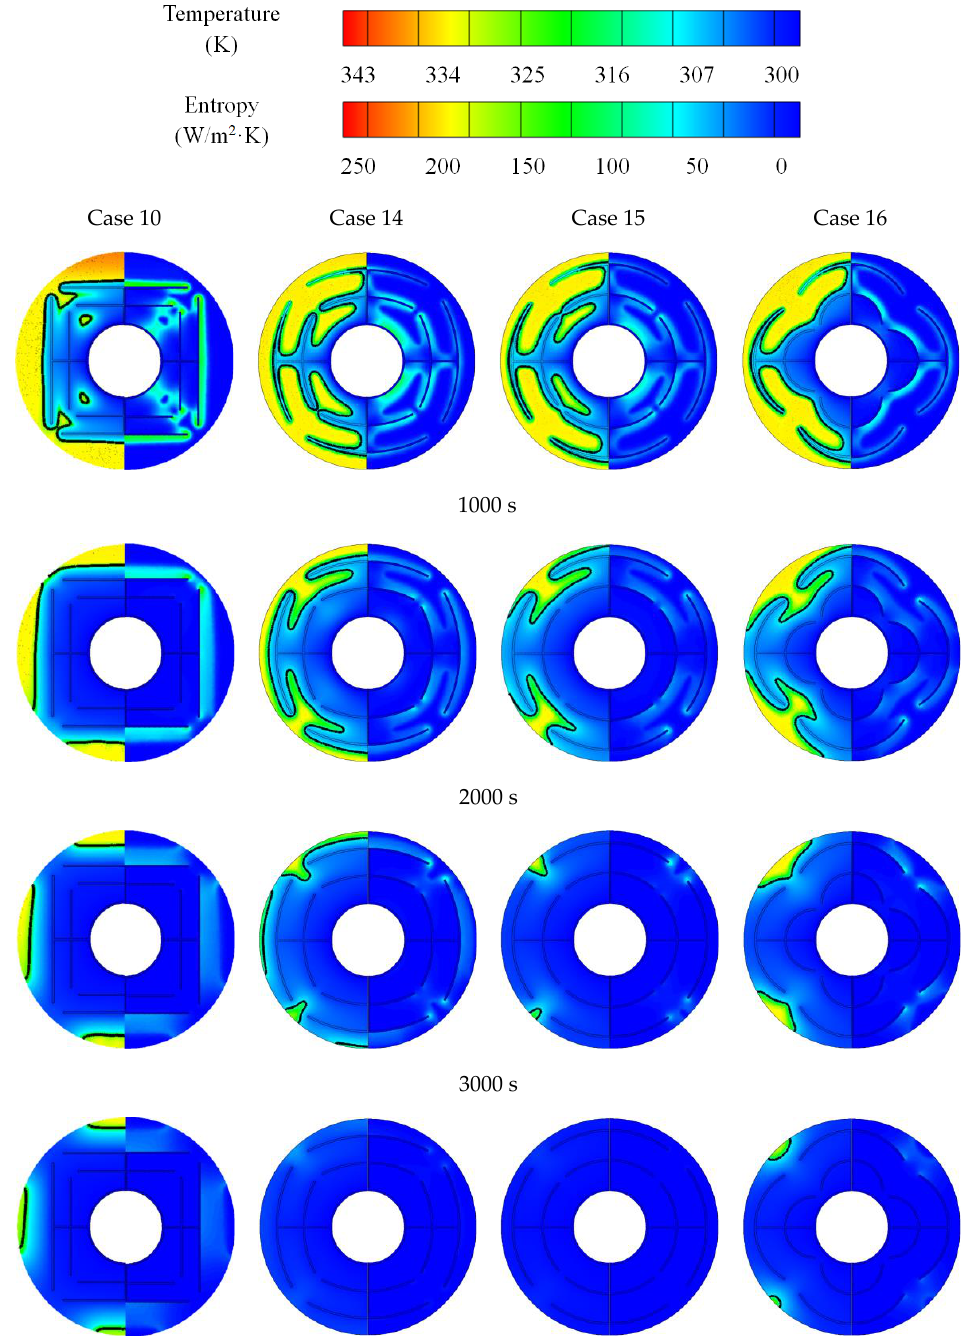
Figure 21. Solidification process for Cases 10, 14 – 16.